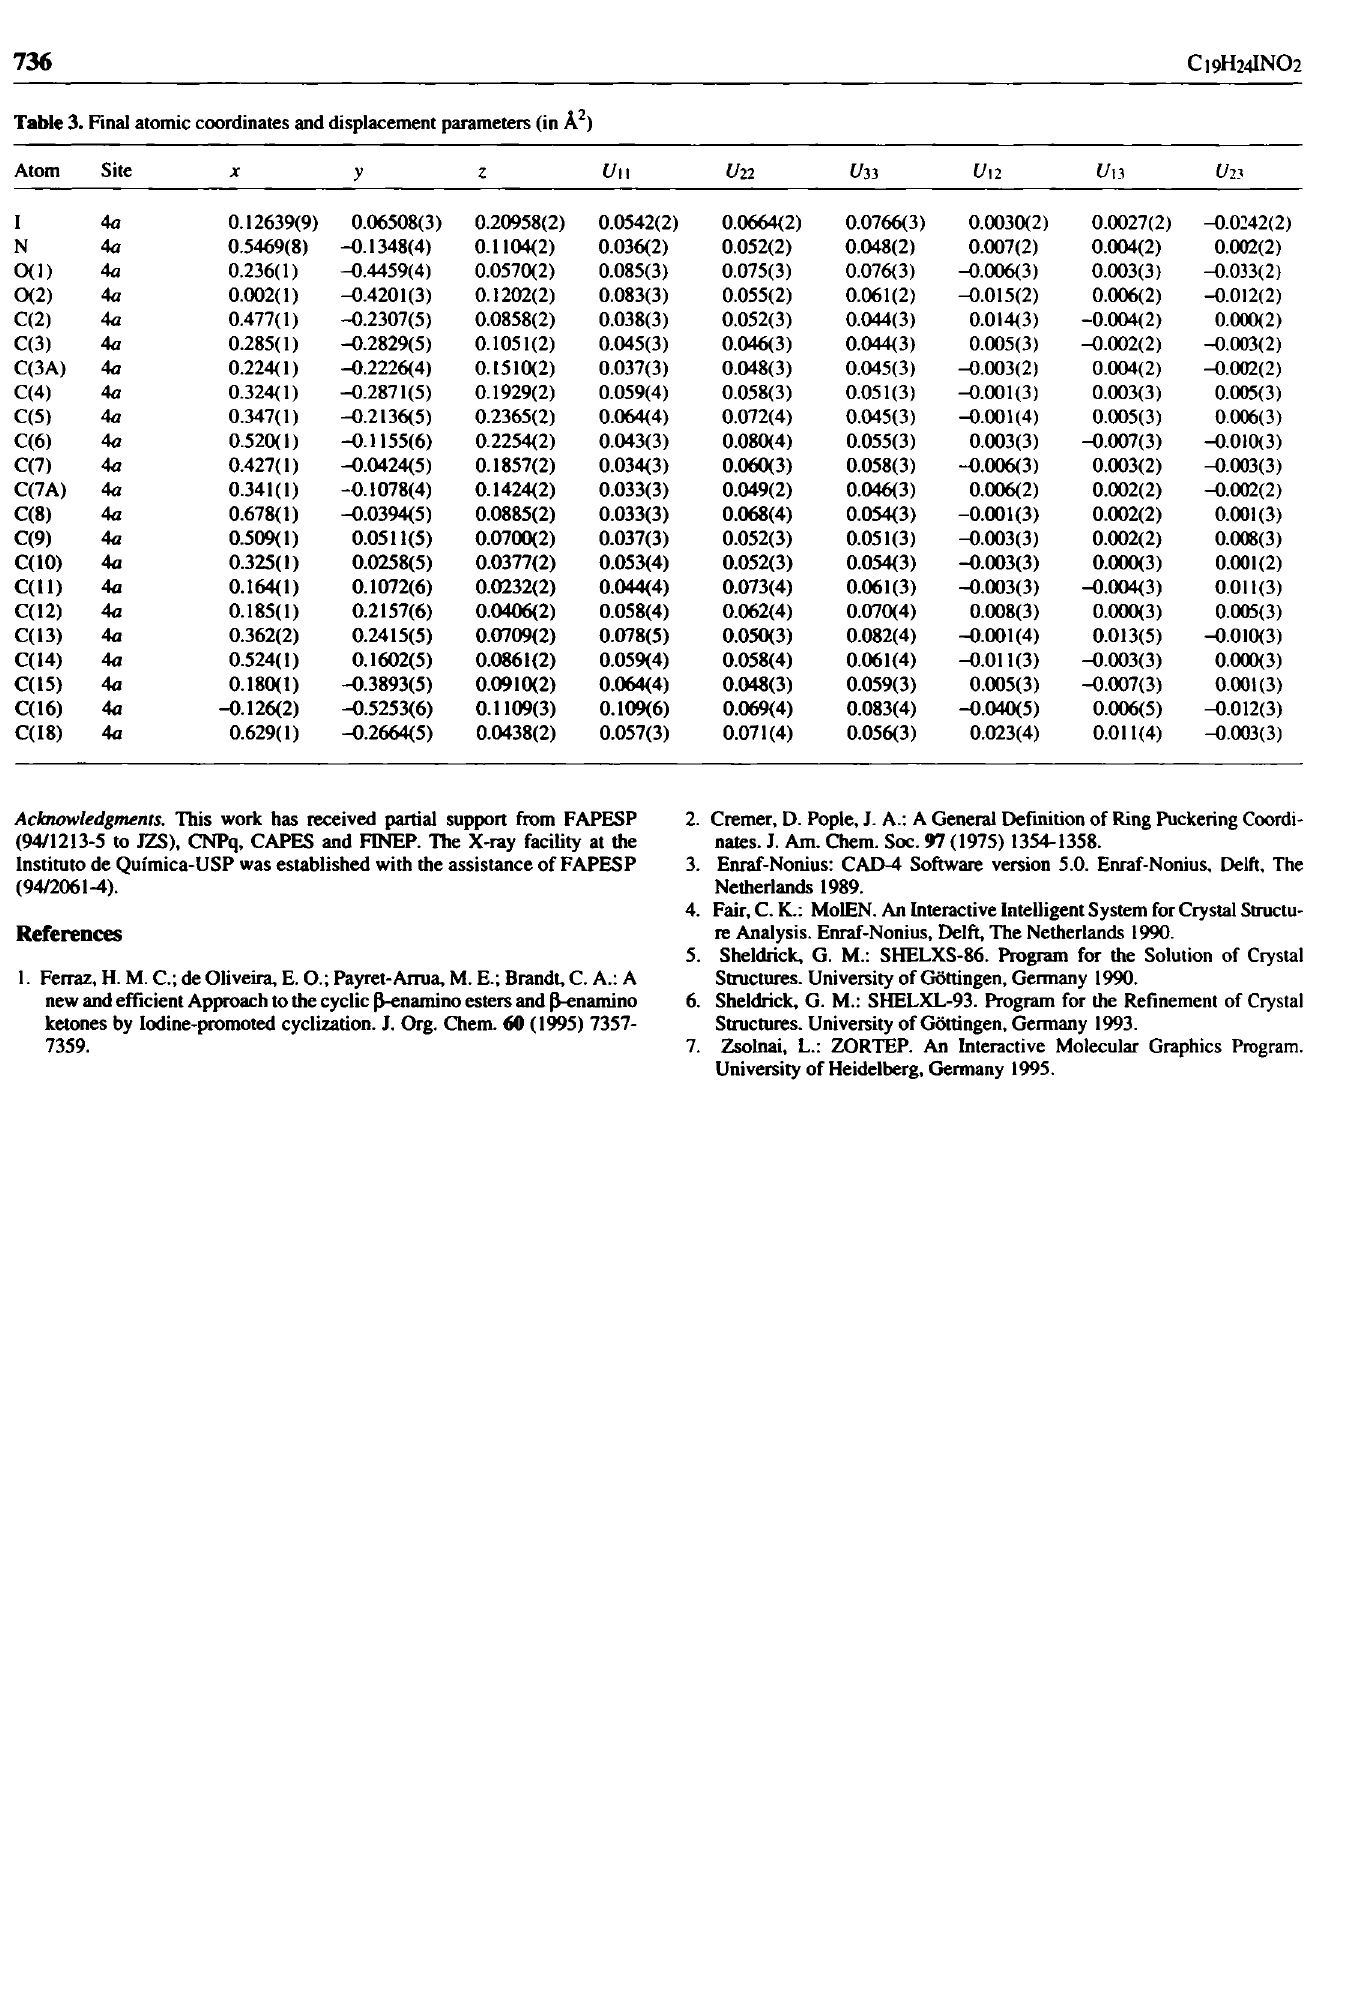
Table 3. Final atomic coordinates and displacement parameters (in